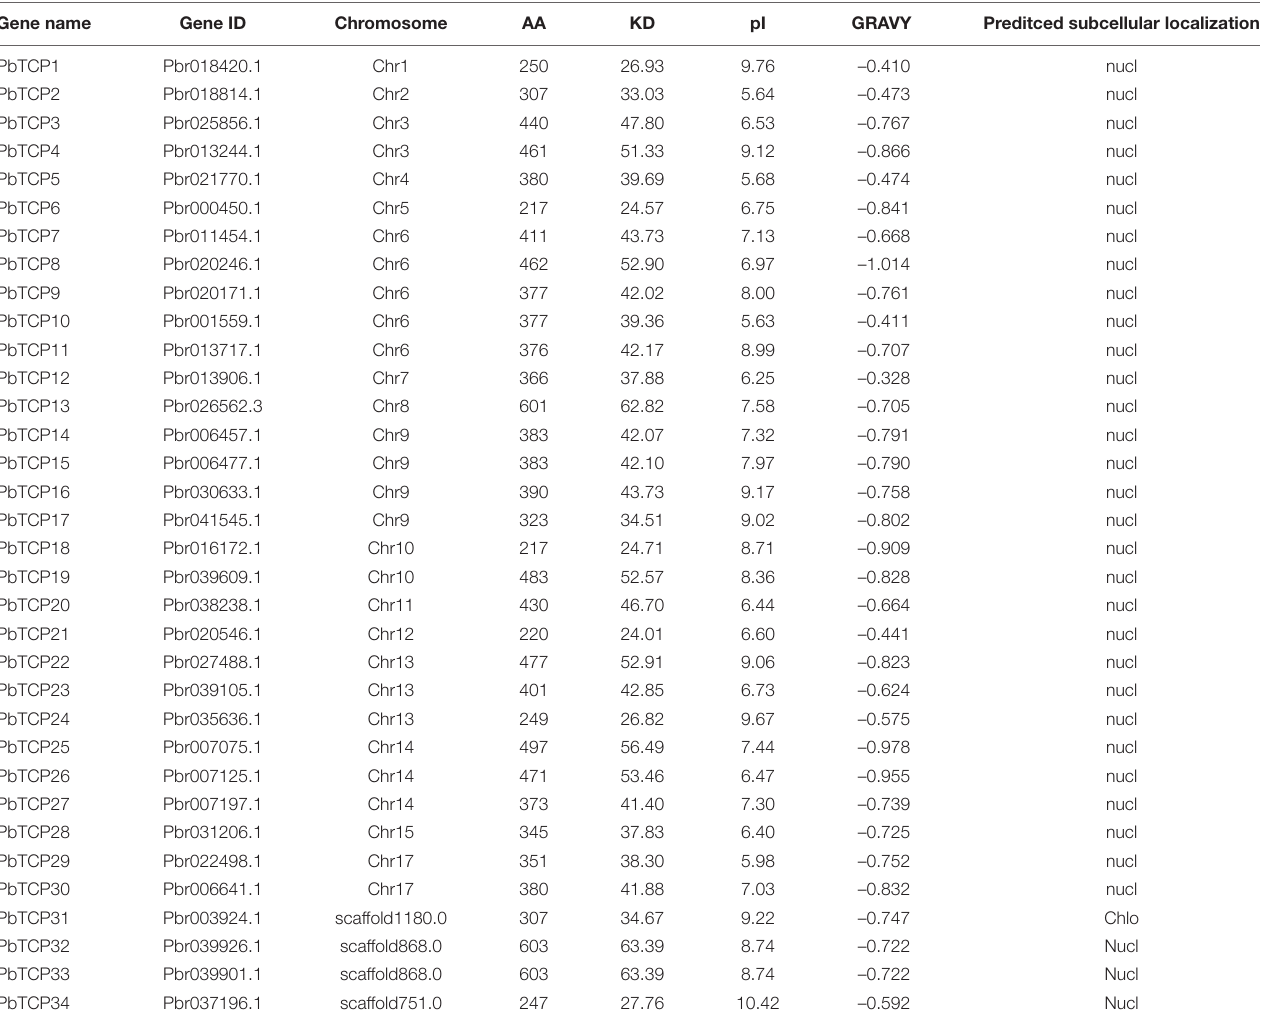
TABLE 2 | Basic information of TCP genes in Pyrus bretschneideri